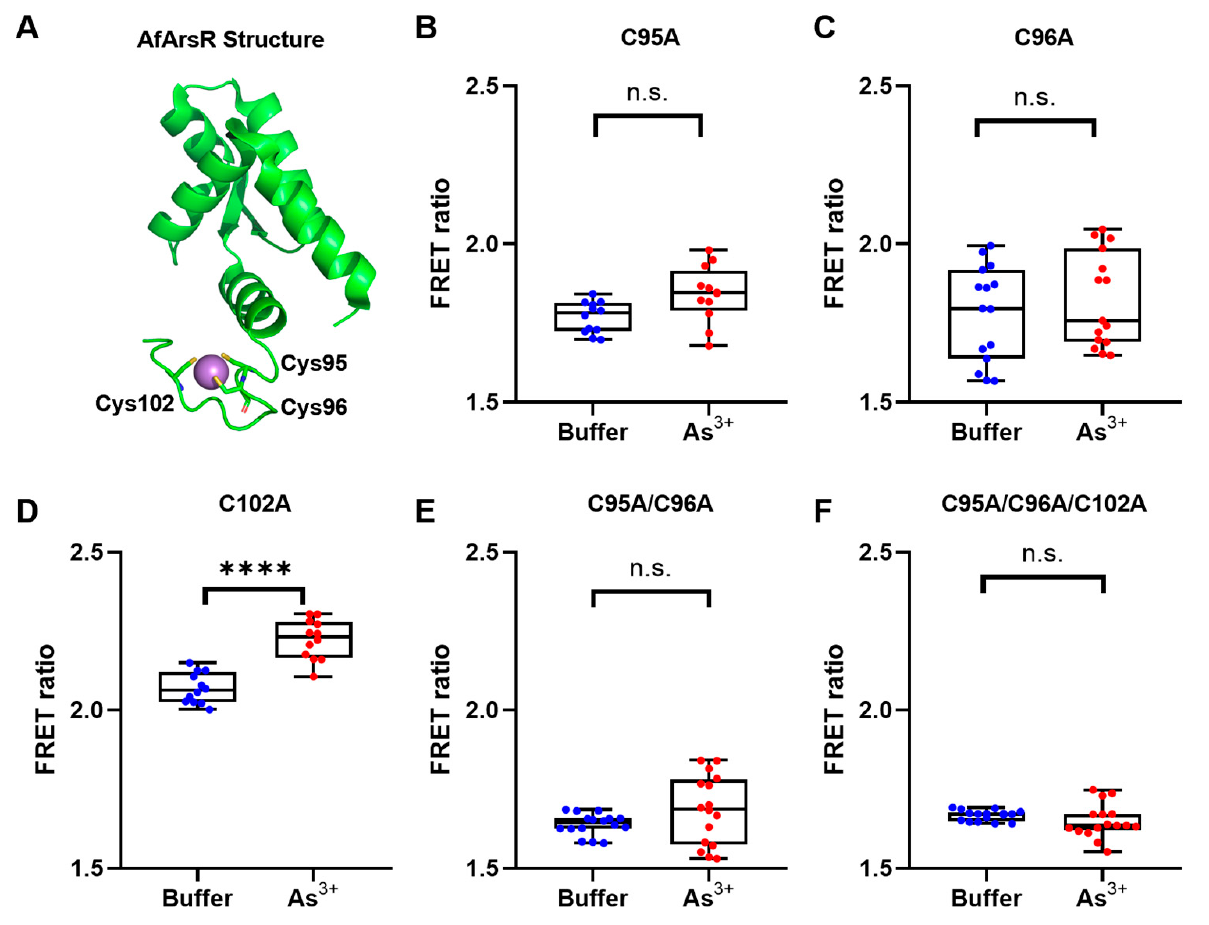
Figure 2. Mutational study of cysteine residues in the AfArsR arsenic binding site using GEAR-CV1. ( A ) The structure of AfArsR (PDB ID: 6J05) with cysteine residues 95, 96, and 102 (sticks) binding As 3+ (purple sphere). FRET ratios of cysteine-mutated variants based on GEAR-CV1, in Tris-buffered saline without (blue) and with (red) 1 mM As 3+ , including single-mutants Cys95Ala ( B ) Cys96Ala ( C ), and Cys102Ala ( D ) double-mutant Cys95Ala/Cys96Ala ( E ), and triple-mutant Cys95Ala/Cys96Ala/Cys102Ala ( F ). Significant differences between pairs are indicated as **** ( p < 0.0001), n.s. not significant ( p > 0.05).